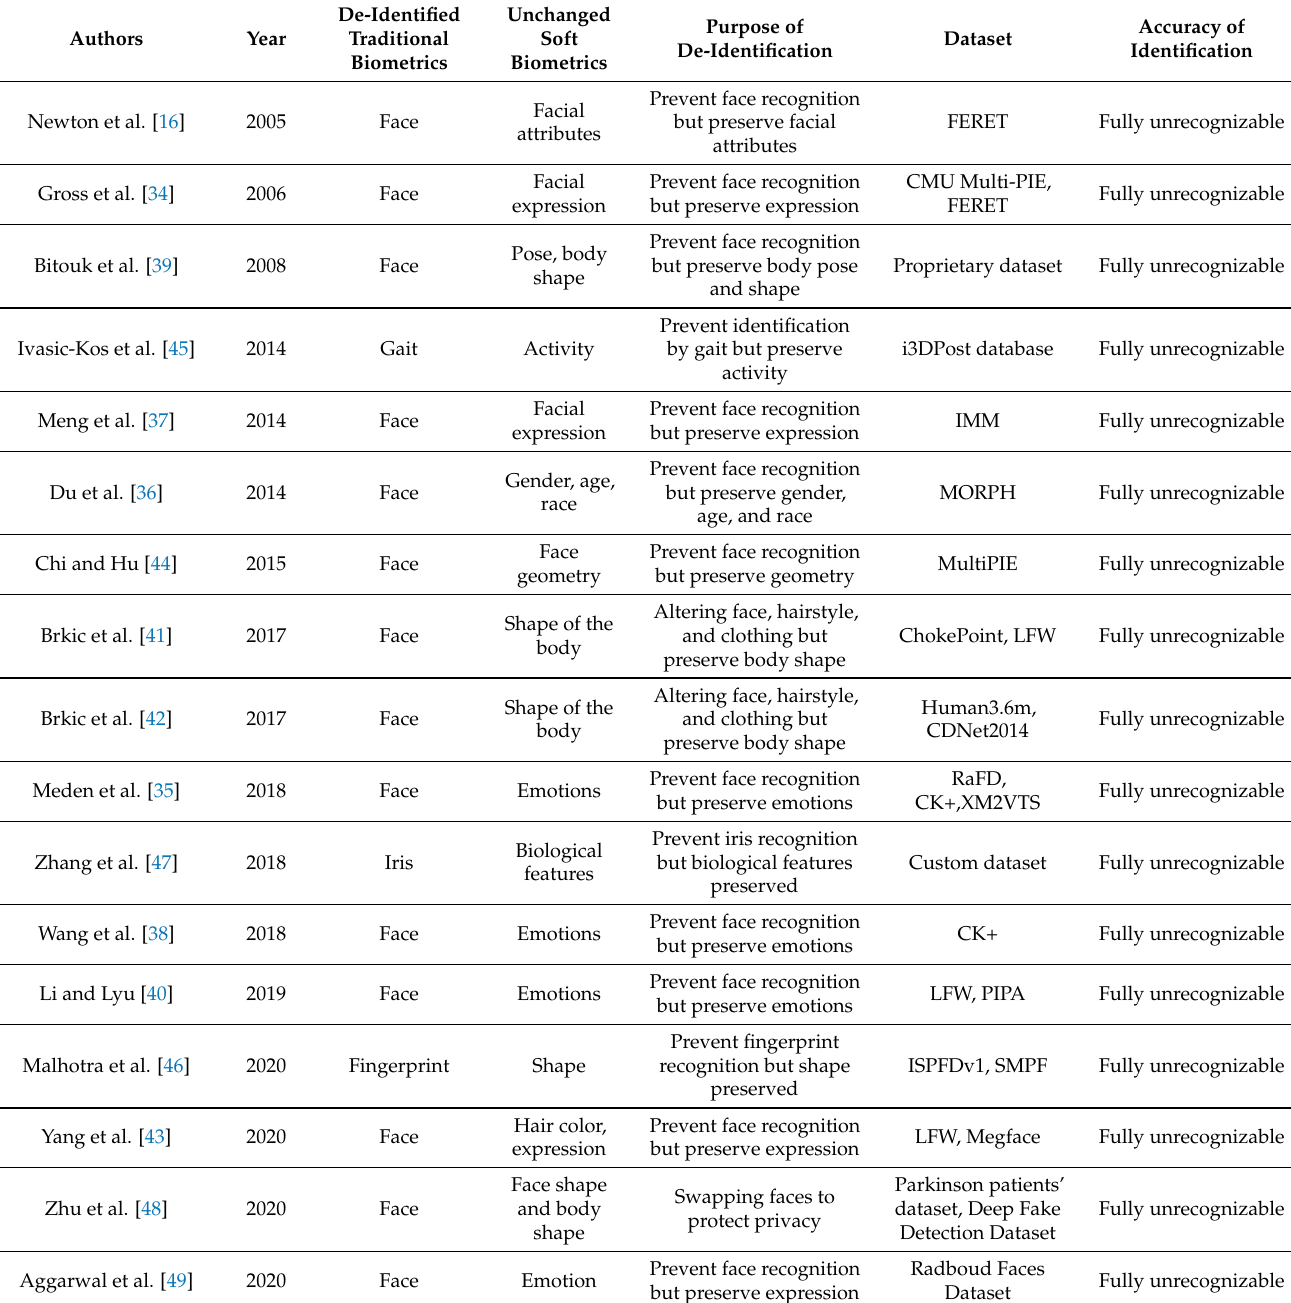
Table 2. Summary of soft biometrics preserving utility lost de-identification